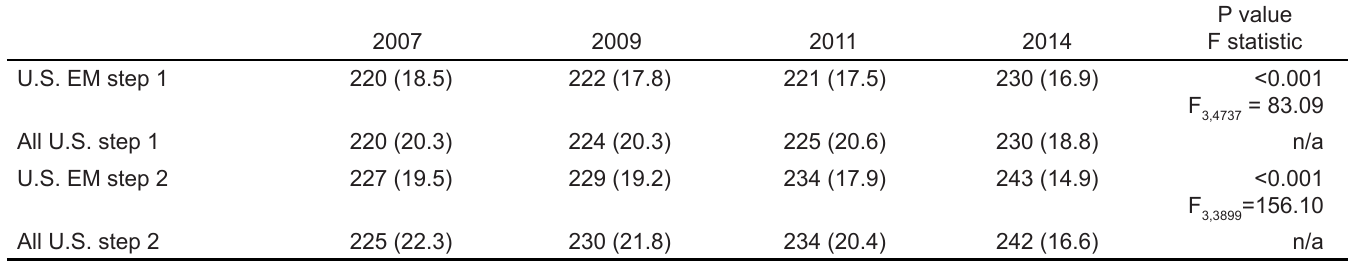
Table 2. USMLE scores among all U.S. seniors participating in the match and U.S. seniors who matched in EM. Scores are presented as mean (standard deviation). P values were generated via ANOVA.